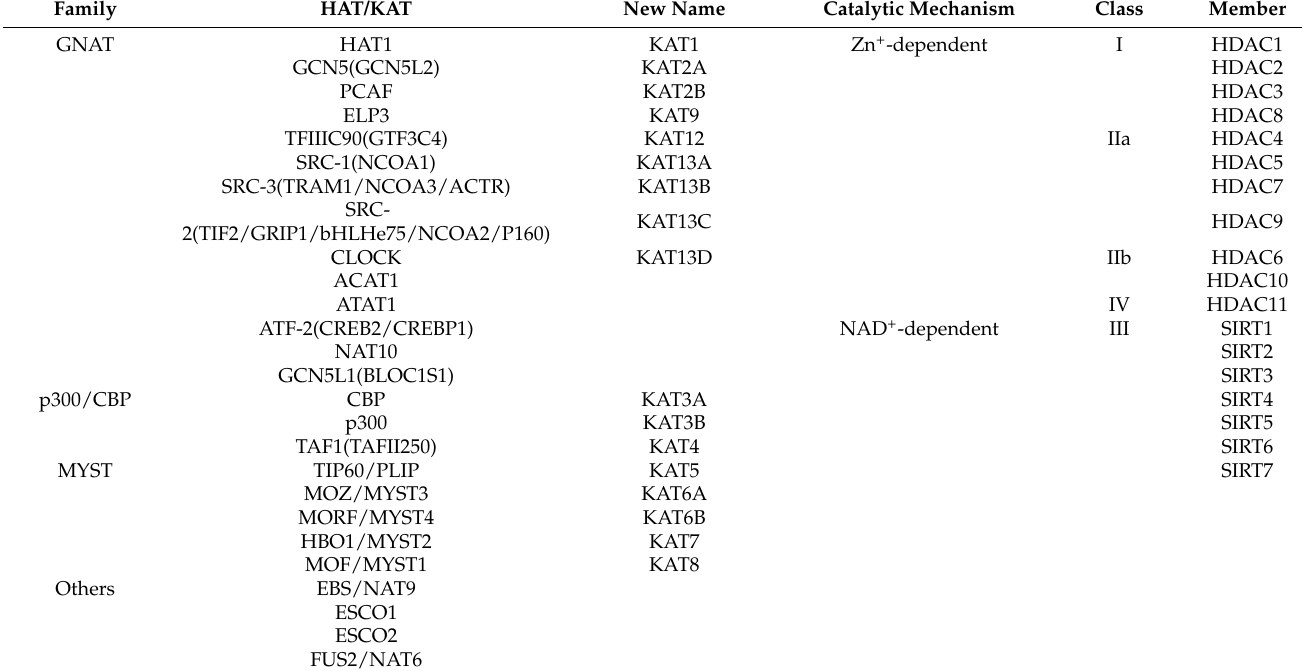
Table 1. Lysine acetyltransferases (KATs) and lysine deacetylases (KDACs). Family HAT/KAT New Name